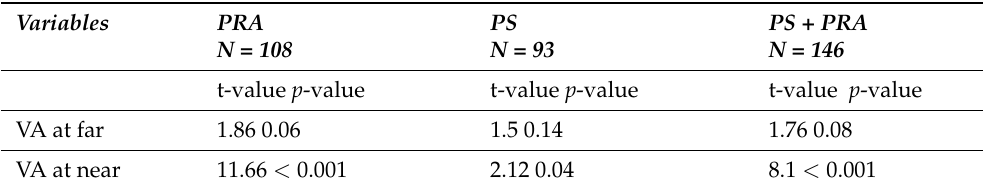
Table 2. Relationship between the amount of binocular visual acuity at far and near, and the degree of stereopsis for PRA and PS using multiple regression analysis. Variables